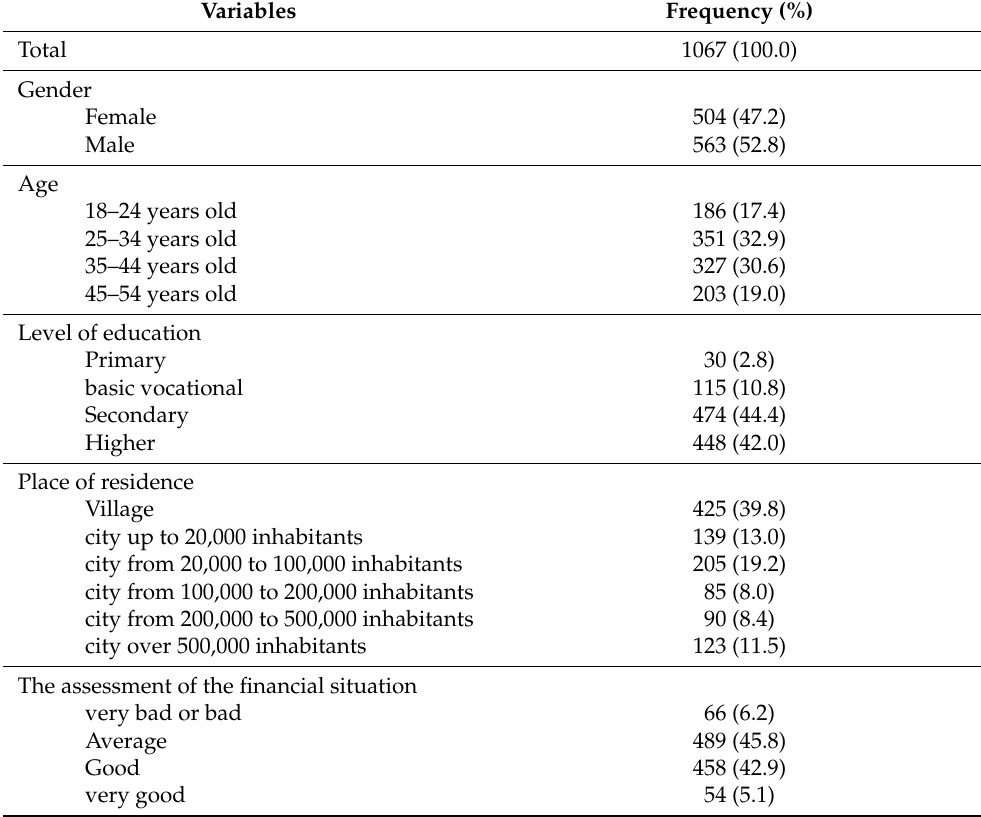
Table 1. The profile of